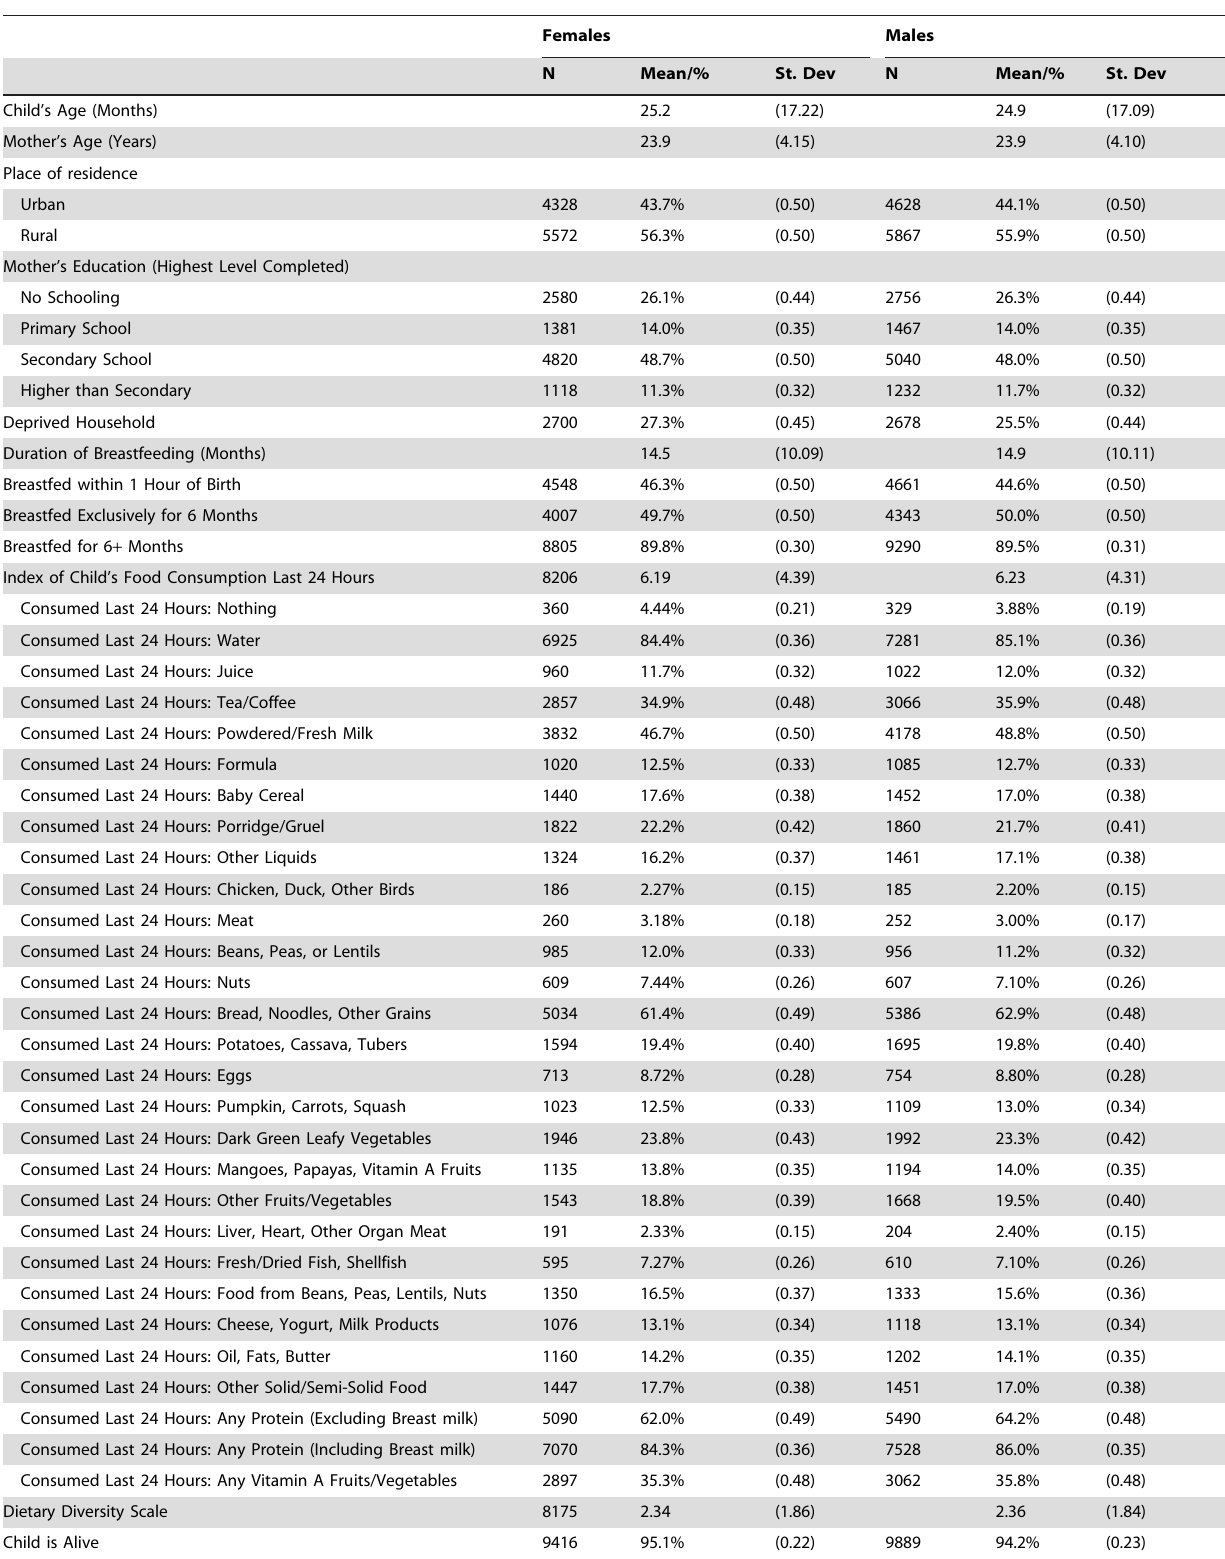
Table 1. Descriptive statistics for all children,